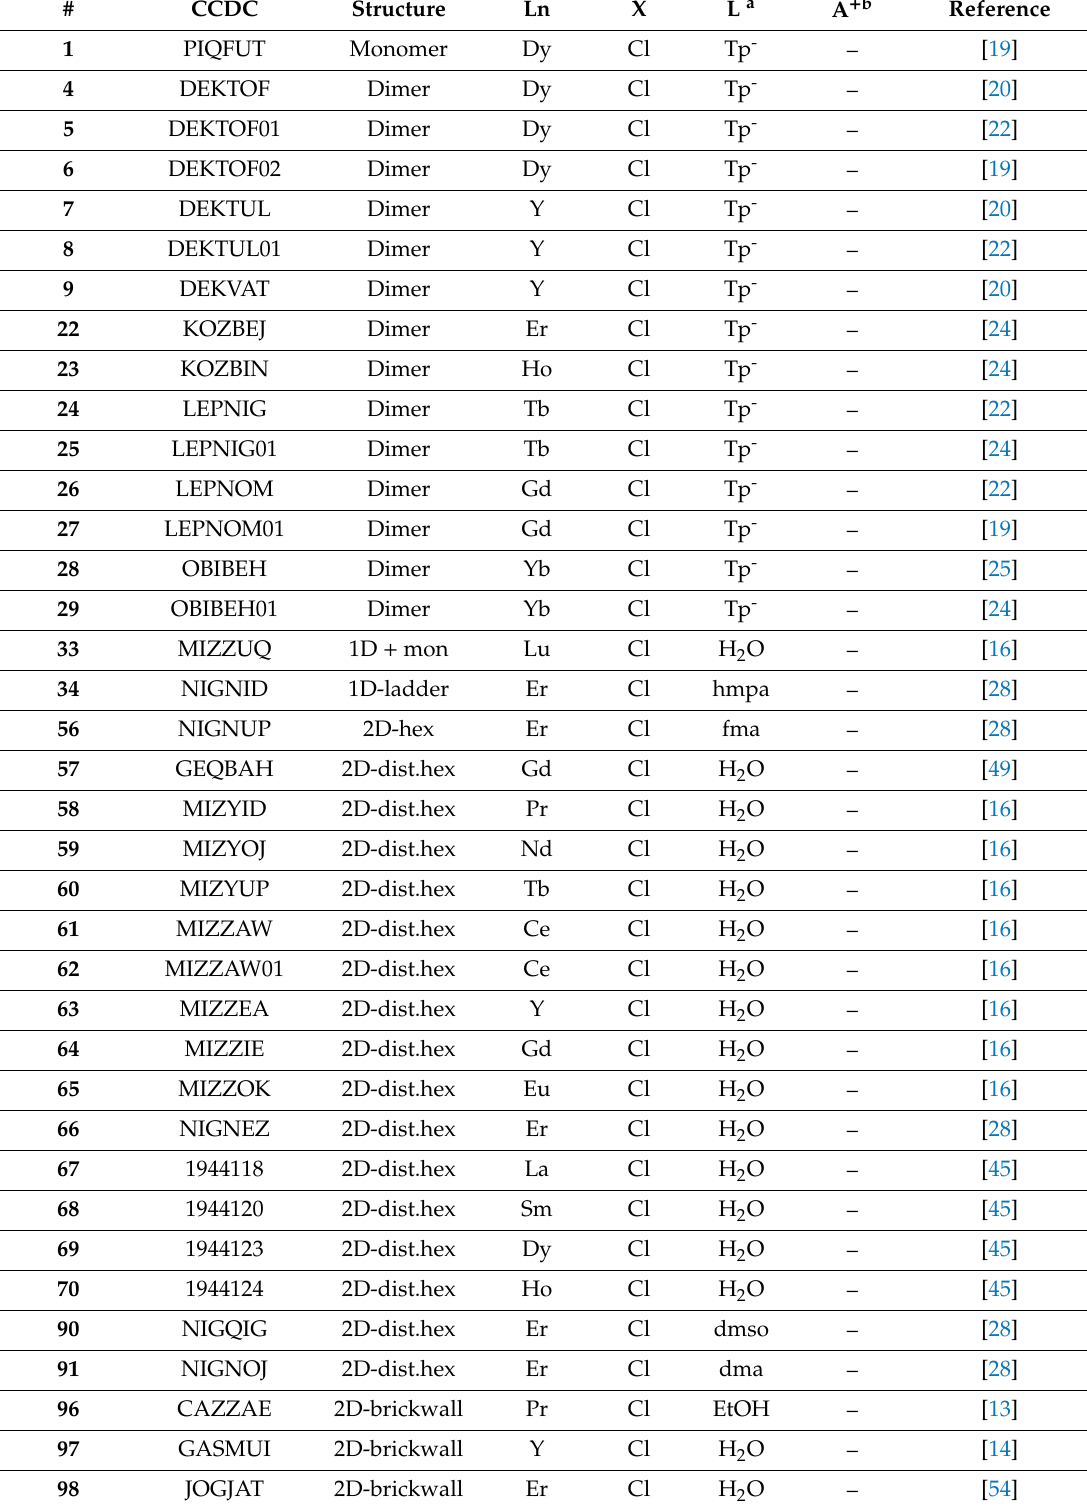
Table 9. Structurally characterized Ln compounds with